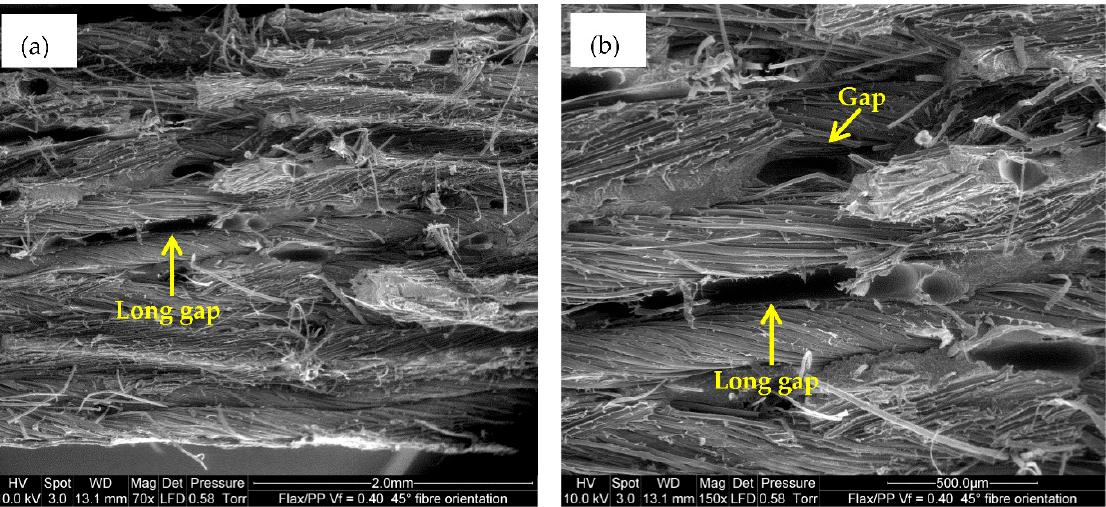
Figure 15. ESEM images of tensile fracture samples: ( a , b ) showing a long gap for a fibre volume fraction and orientation of 0.40 and 45°, respectively, at two different magnifications .